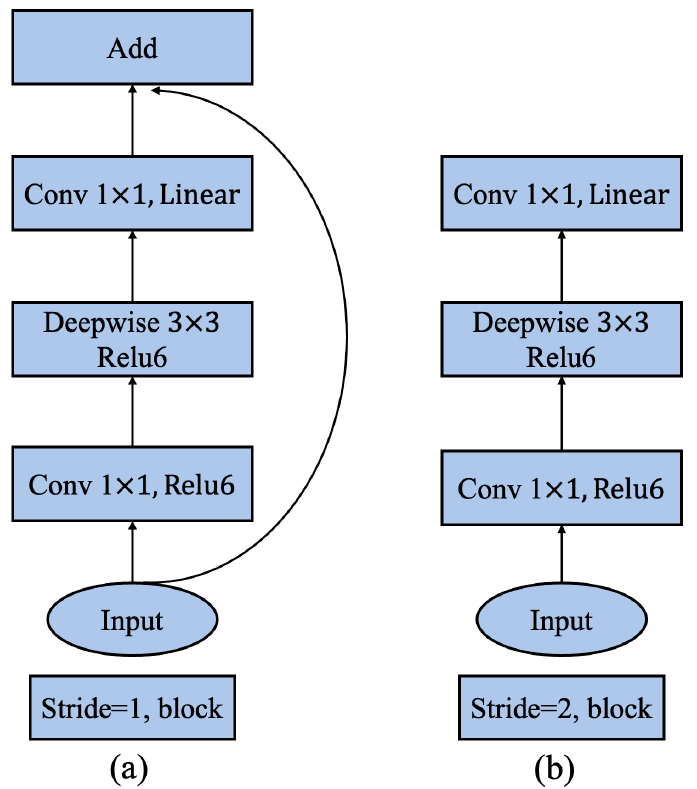
Figure 2. MobileNet V2 solves the degradation issue associated with the increase in the number of network layers by introducing the inverted residual structure and the shortcut. ( a ) Is the residual block when the step size is 1, and ( b ) is the residual block when the step size is 2.